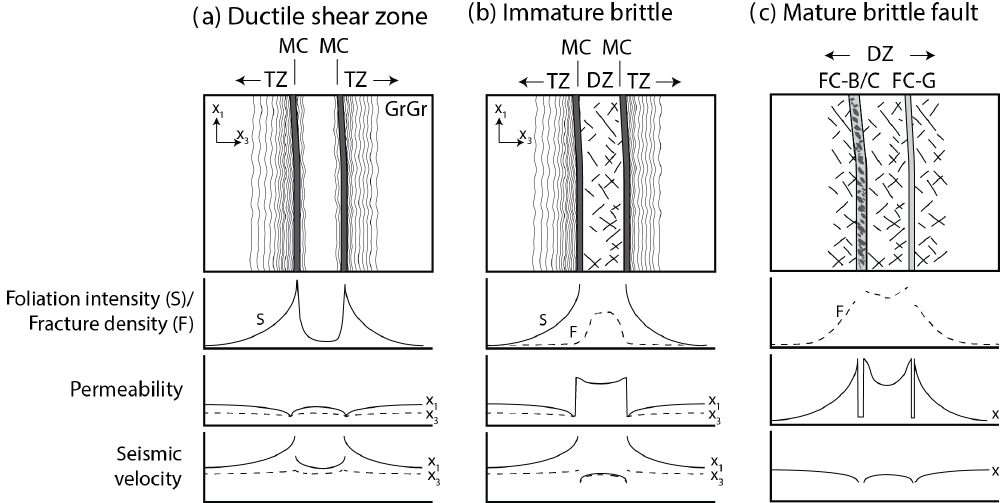
Figure 5. Conceptual model for the characteristics of faults in crystalline rock and their associated petrophysical properties during transition from ductile to brittle deformation conditions. (a) Formation of ductile shear zones with increasing foliation in the transition zone (TZ) nearest the mylonitic core (MC), (b) immature brittle fault with ductile transition zone preserved outside the MCs and the damage zone (DZ) between, and (c) mature brittle fault and DZ, where the brittle features dominate the fluid flow and elastic properties near the brittle fault cores dominated by gouge (FC-G) and breccia/cataclasite (FC-B/C) (after Faulkner et al.,